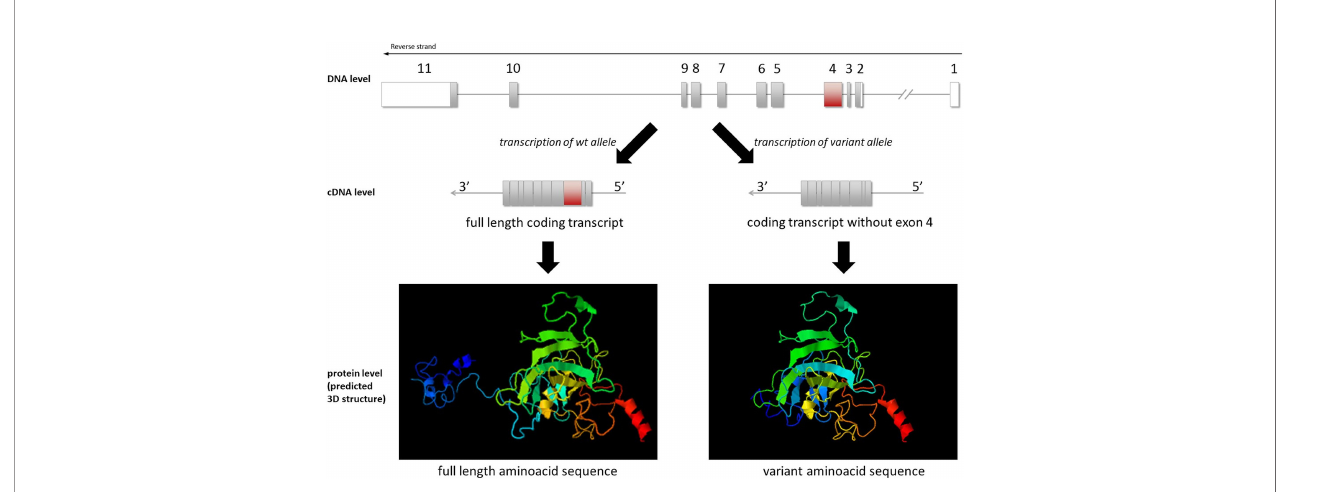
FIGURE 4 | Illustration of TP53 (NM_000546.5) exon 4 skipping at the DNA, cDNA, and protein levels. 3D modeling of the wild-type and variant protein indicated different structures (visualized by JSmol).